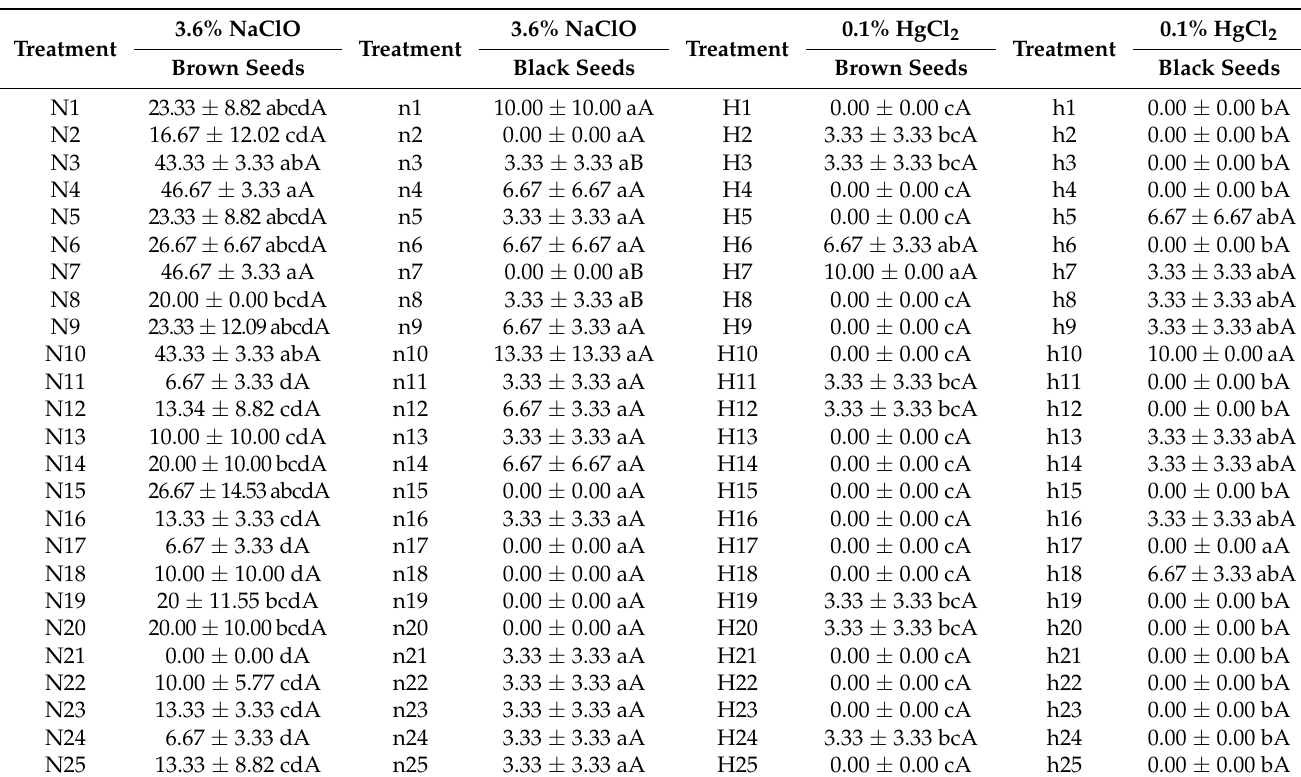
Table 7. Seedling survival percentage of Suaeda aralocaspica cultured with different treatments after 20 days